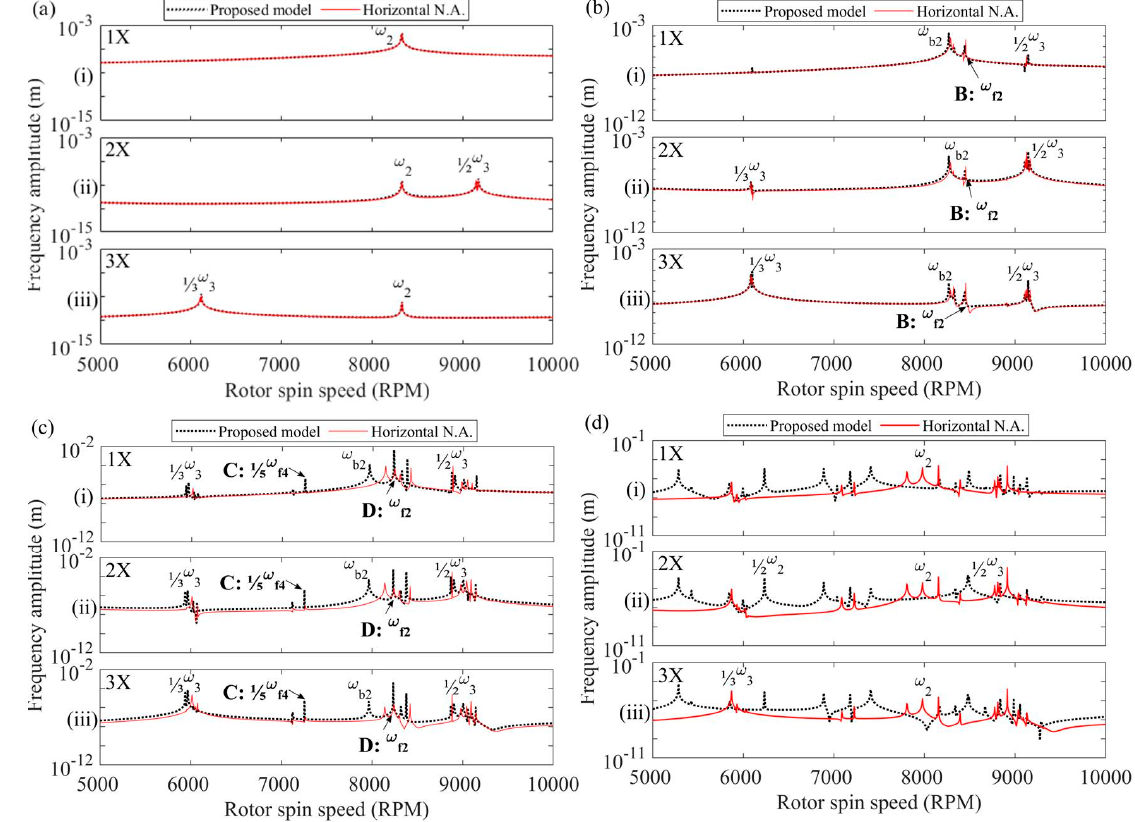
Figure 15. Vertical amplitude of the first three frequency components in the vicinity of the second critical speed: ( a ) non-cracked, ( b ) μ = 0.2, ( c ) μ = 0.5 and ( d ) μ = 0.8 for ( i ) 1X, ( ii ) 2X and ( iii ) 3X frequencies.